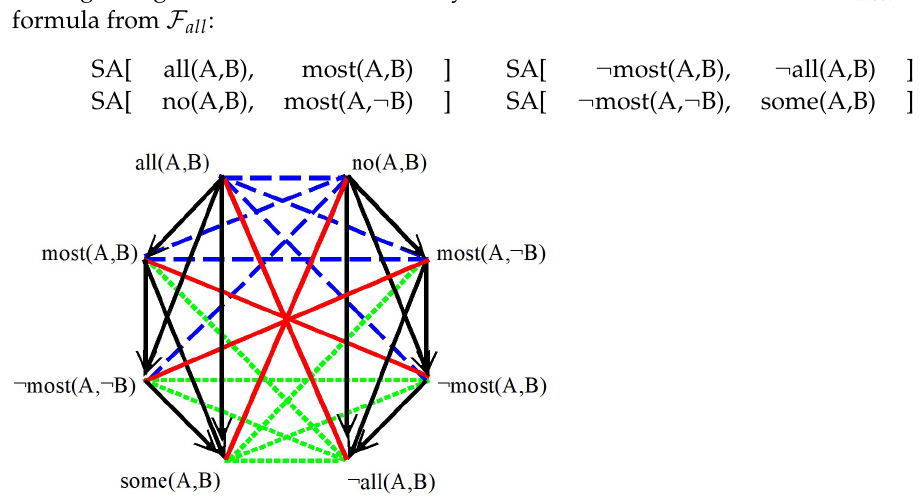
Figure 8. Octagon for F allmost , relative to SYL